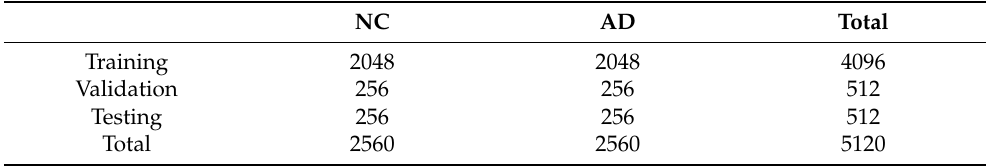
Table 2. Division of